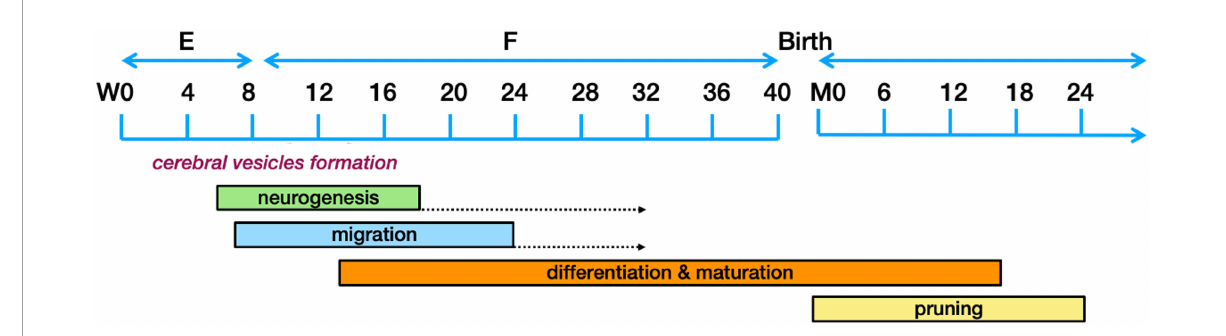
FIGURE3 Schematic representation of the human brain development timeline. The dotted arrows designate a reduction in the rate of neurogenesis. Figure adapted from Stagni et al. (2015), obtained by Elsevier (No. 5410821023270) under a creative commons license 3&4.